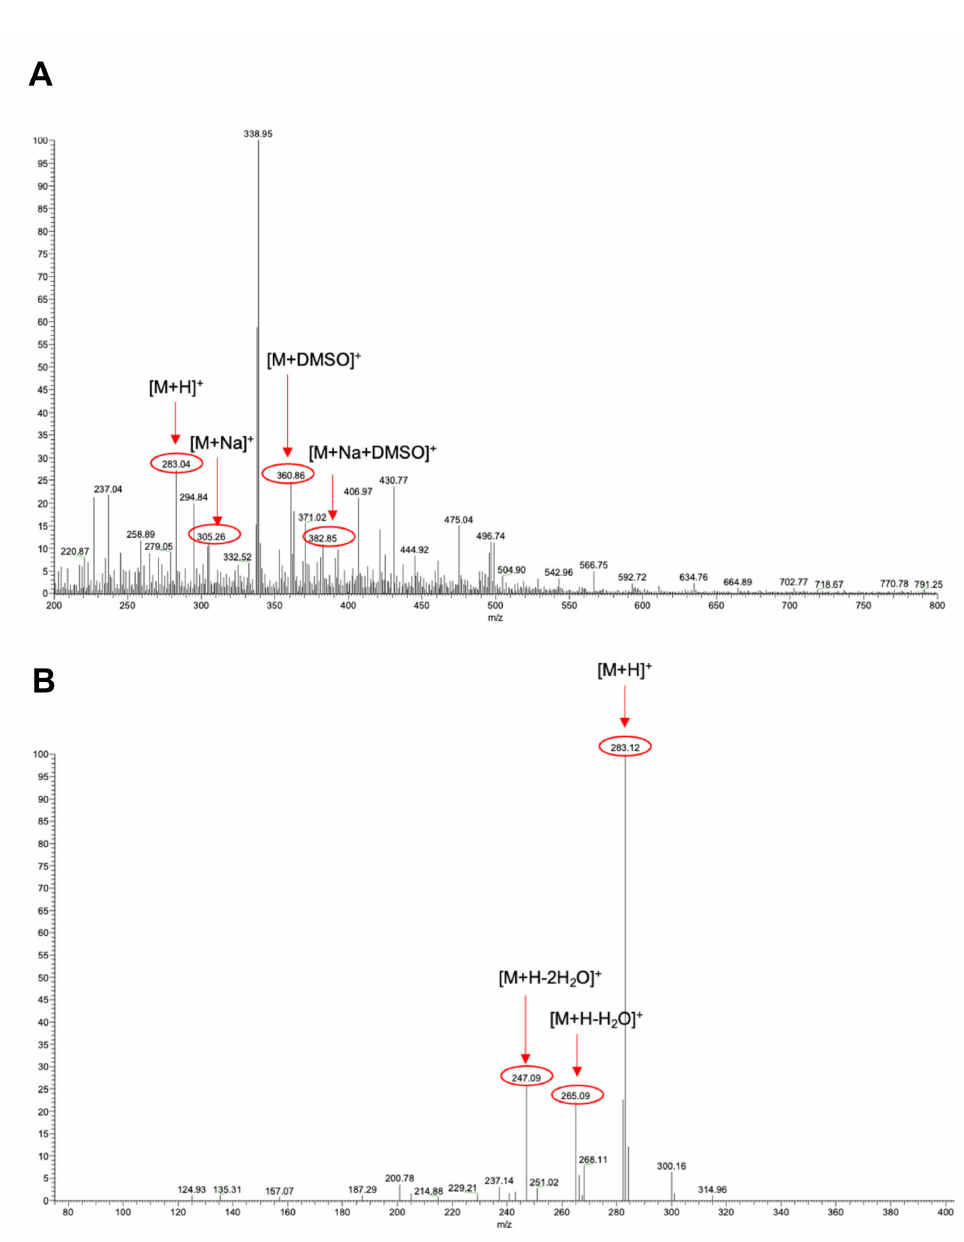
Figure 3. ESI-MS spectra of the sample manually collected from HPLC-DAD of the hydroalcoholic phyto-extract in 90% ethanol. ( A ) Full ESI-MS spectrum. ( B ) Fragmentation spectrum resulting from the CID experiment carried out on the isolated signal at m/z = 283.12 (normalized collision energy =